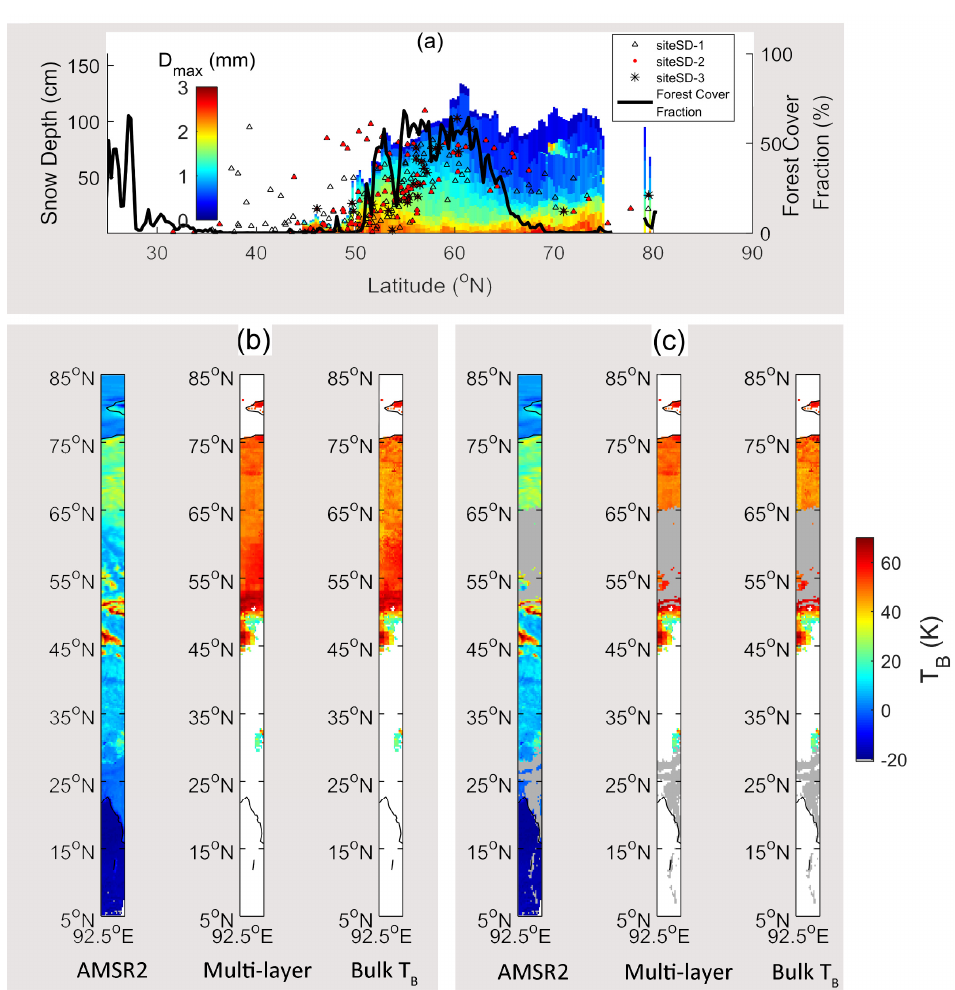
Figure 18. Comparison of GLDAS+SNTHERM+MEMLS-simulated T B with the AMSR2 observations on February 28, 2017: ( a ) The comparison of GLDAS+SNTHERM-simulated snow depth with that measured at meteorological stations at the same longitude. siteSD-3 used the stations placed in 90–95°E, whereas siteSD-2 and siteSD-1 contained observations from wider longitude ranges in 80–105°E and 70–115°E, respectively. In both ( b ) and ( c ), from left to right, are the 18.7–36.5 brightness temperature (T B ) difference for vertical polarization from the AMSR2 measurements, MEMLS multiple-layer T B simulation, and MEMLS bulk T B simulation. The white area in the MEMLS simulation is from snow-free pixels. The only difference between ( b ) and ( c ) is that the area of forest cover fraction >20% was masked by the grey color in ( c ).